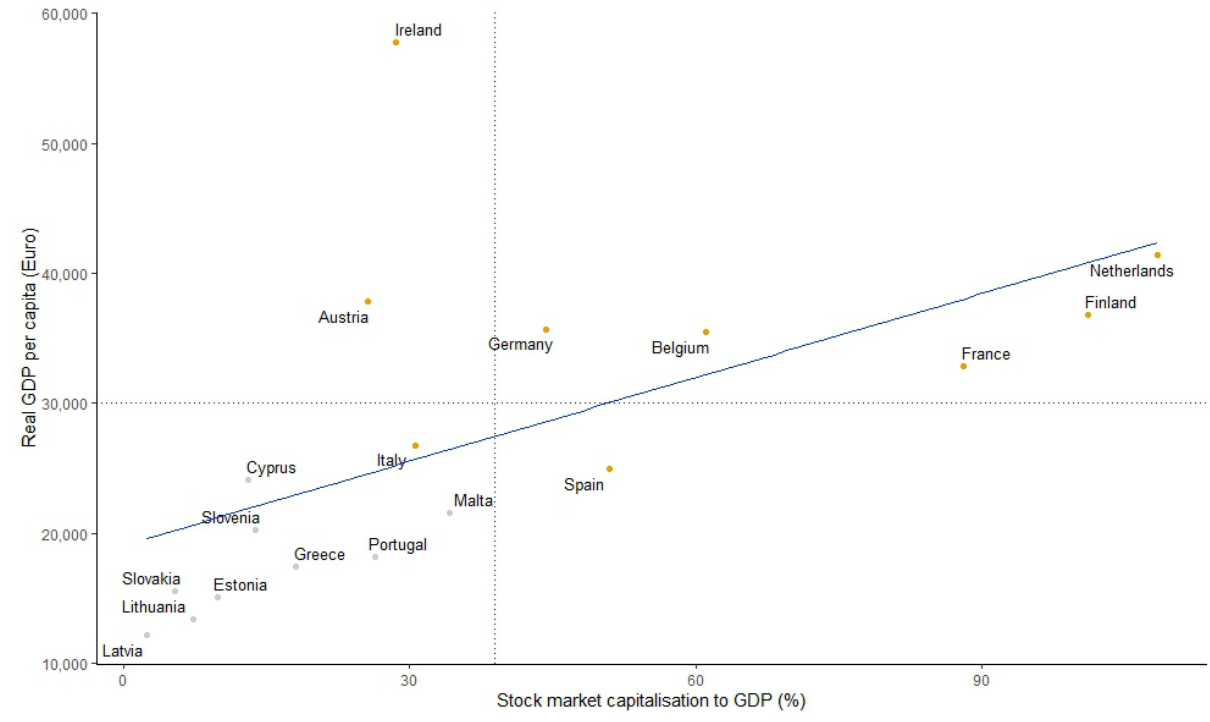
Figure 4. Relationship between real GDP per capita (Euro) and stock market capitalisation to GDP (%), 2018. Grey points represent small financial centers, while yellow points represent middle-large financial